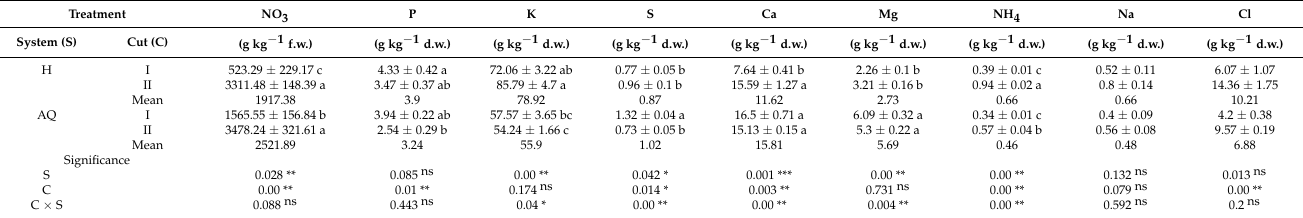
Data represent the mean ± s.e. (n = 3). Different letters indicate significance based on Tukey’s HSD post hoc test. ns, *, **, and *** indicated non-significant and significant effects at p < 0.05, 0.01, and 0.001, respectively.